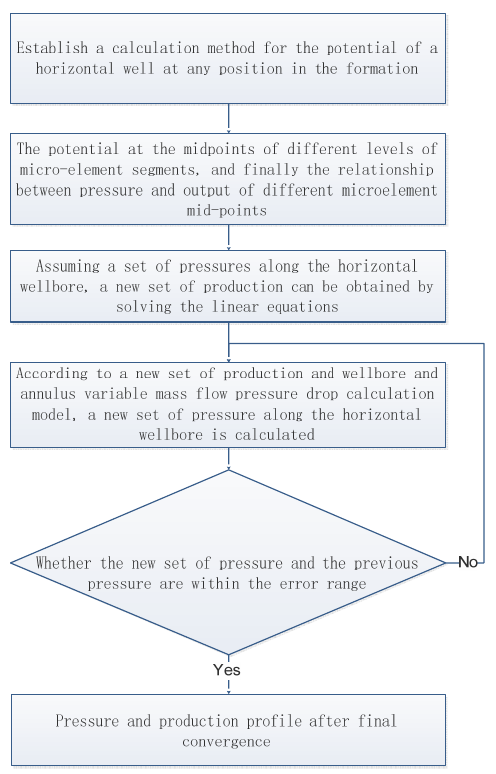
Figure 5. The coupling model calculation flowchart.